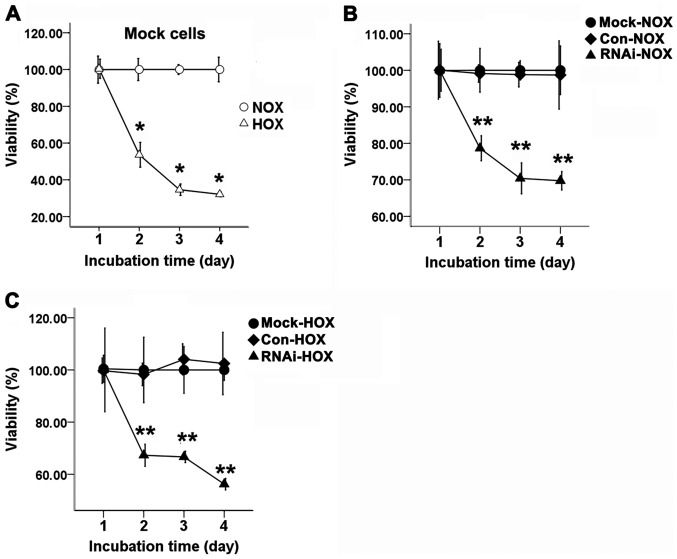
The effect of HIF-1α on cell viability of SCC-15 cells. (A) The viability for Mock cells treated with DFO compared to normoxic cells [Cell viability = (ODHOX-ODblank)/(ODNOX-ODblank)]. (B) The difference of viability between Mock, Con and RNAi cells in normoxia [Cell viability = (ODexperiment-ODblank)/(ODMock-NOX-ODblank)]. (C) The difference of viability between Mock, Con and RNAi cells under hypoxic condition [Cell viability = (ODexperiment-ODblank)/(ODMock-HOX-ODblank)] (bars, ± SD, *p<0.01, compared to normoxic Mock group, **p<0.01, compared to Mock and Con cells). NOX, normoxia; HOX, hypoxia.